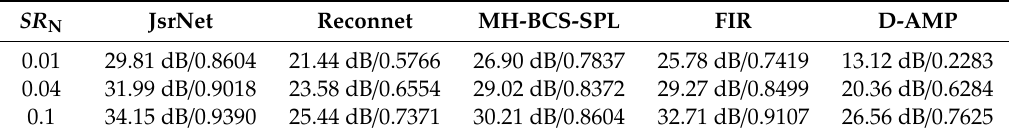
Figure 7. Visual comparisons of WallPushups_g10 . ( a ) JsrNet, ( b ) Reconnet, ( c ) MH-BCS-SPL, ( d ) FIR, ( e ) D-AMP. Table 1. Reconstruction performance comparisons (PSNR / SSIM).